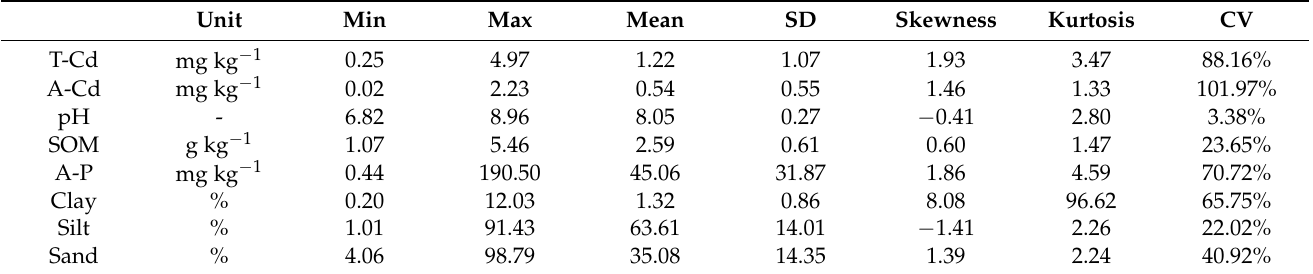
Table 2. Descriptive statistics of soil properties and the contents of total and available Cd in soils.